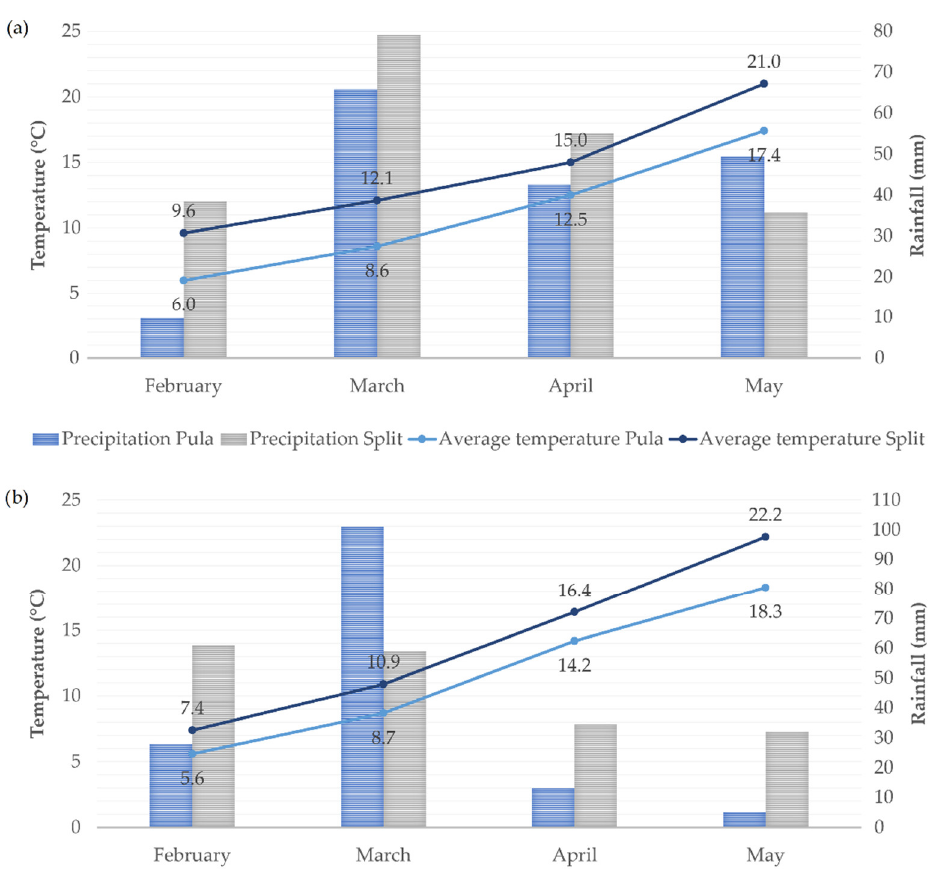
Figure 1. Average air temperatures and rainfall in the ( a ) first and ( b ) second year at the Pula and Split locations .